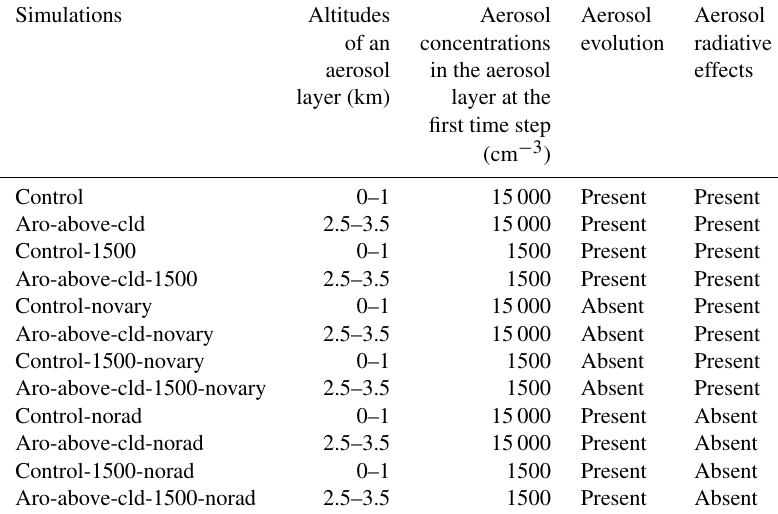
Table 1. Summary of simulations.